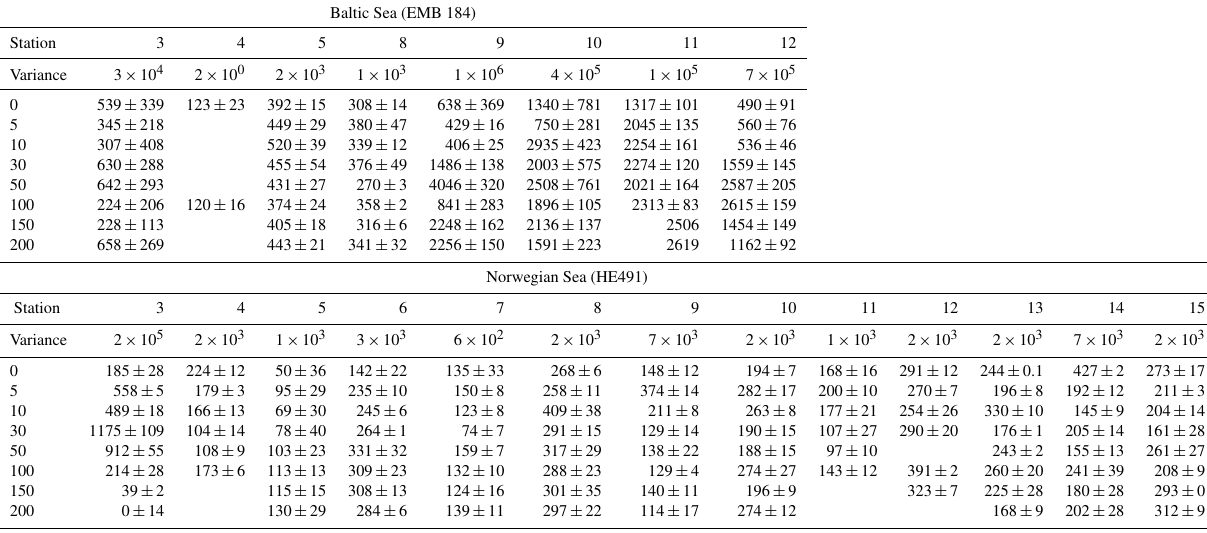
Table 3. TEP concentration (µgXGeqL − 1 ) at various depths (in metres), providing an indication of the vertical distribution; variance between TEP concentrations at all depths is shown as an indicator for homogeneity (µgXGeq 2 L − 2 ). Baltic Sea (EMB 184)